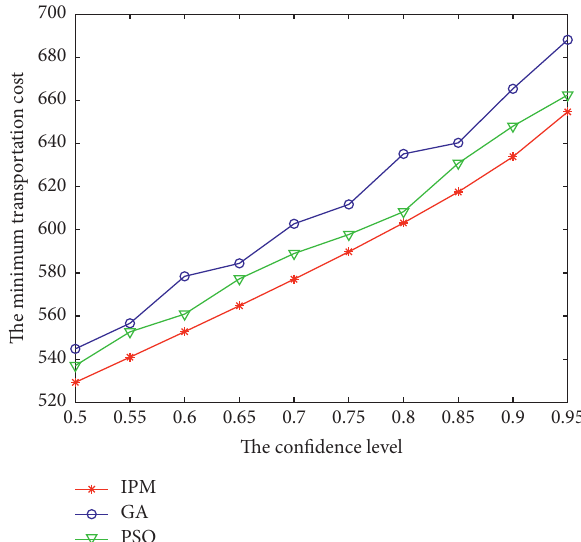
Figure 6: Sensitivity analysis of the chance-constrained model with nonlinear